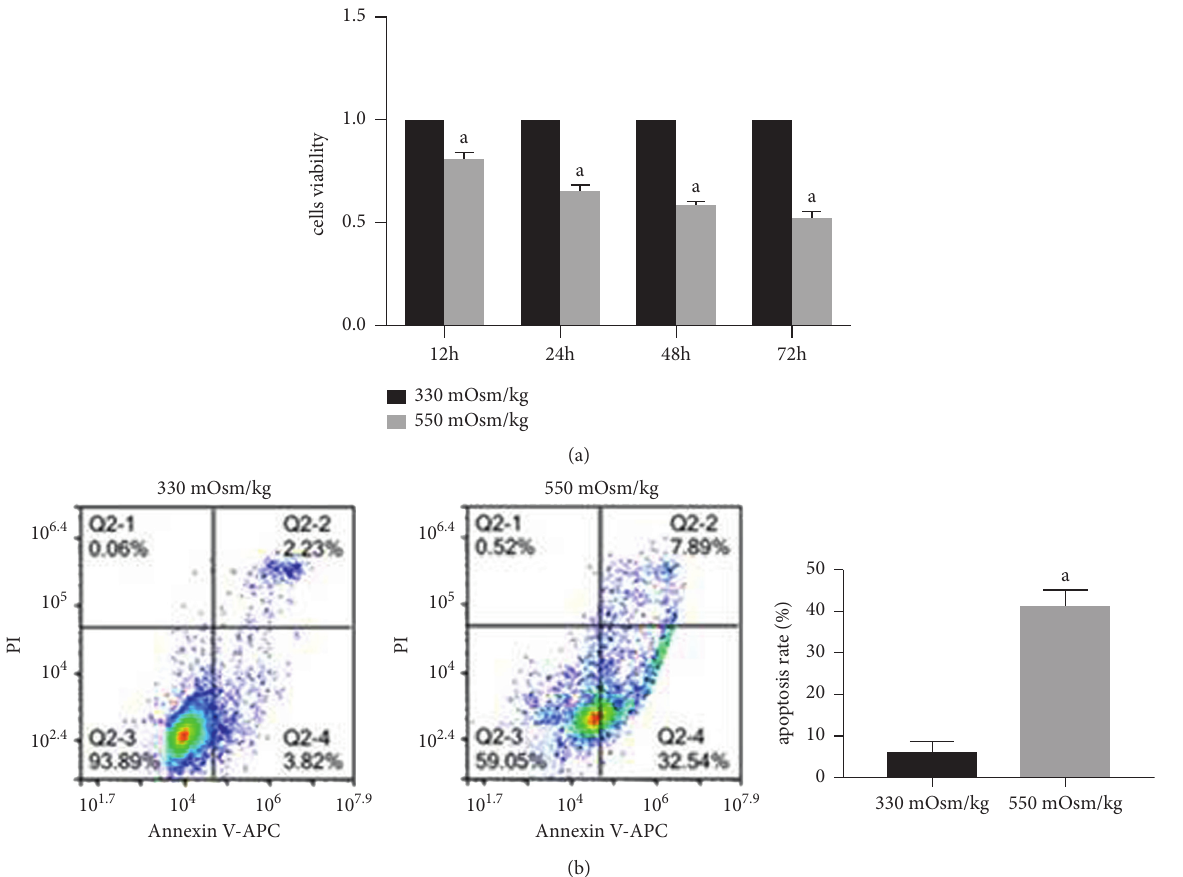
Figure 1: Hyperosmolarity inhibited NP cell proliferation and promoted NP cell apoptosis. (a) The proliferation of rat NP cells detected by CCK-8. (b) Flow cytometry analysis of cell apoptosis rate under different osmotic pressures (330 mOsm/kg and 550 mOsm/kg). Data are expressed as mean ± SD. (A) indicates a significant difference ( p < 0 . 05) when compared with